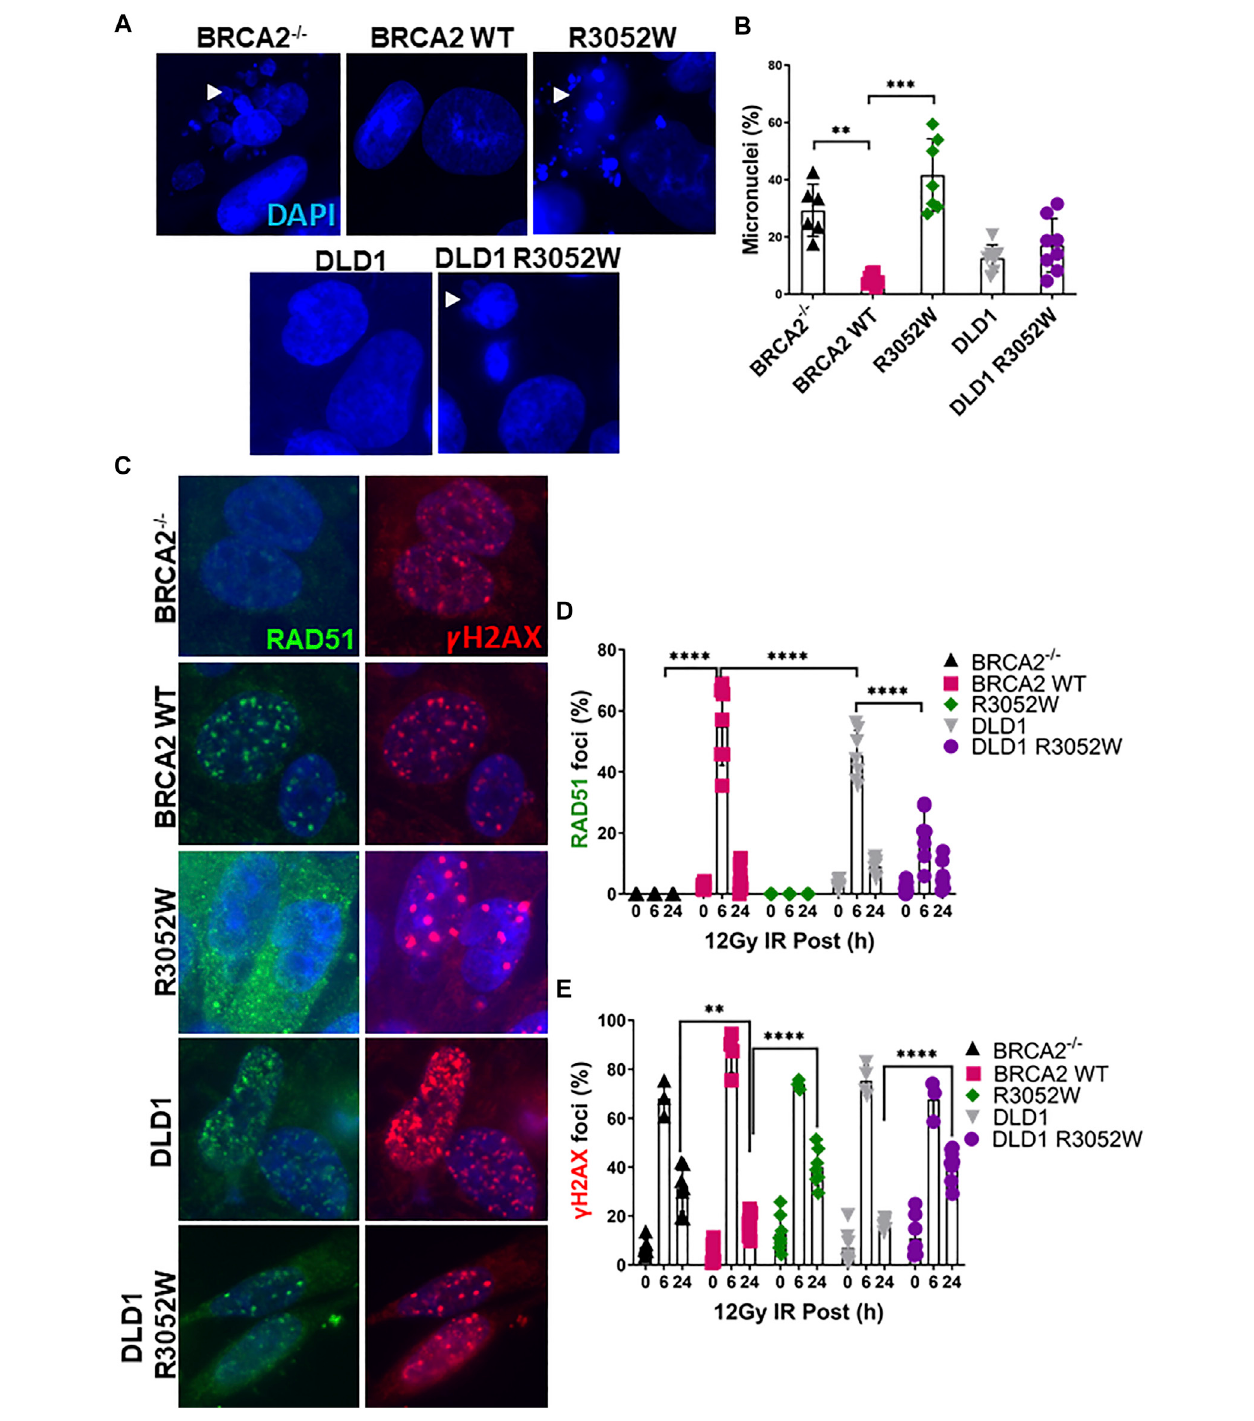
FIGURE 2 | The BRCA2 R3052W mutation exacerbates micronuclei formation and interferes with RAD51 foci formation in DLD1 parental and BRCA2 wild-type cells. (A) Representative immuno fl uorescent images of micronuclei (blue) in a DLD1 BRCA2 knockout cell line (top) expressing WT or the R3052W mutant and parental DLD1 cells (bottom) compared to a stable cell line expressing the R3052W protein. (B) Quanti fi cation of the percentage of cells with micronuclei. (C) Representative immuno fl uorescent images of RAD51 (green) and gammaH2AX (red) foci, and DAPI staining to visualize nuclei (blue). Cells were fi xed and imaged 6 h post-IR (12 Gy). (D) Quanti fi cation of the percentage of cells with RAD51 foci. (E) Quanti fi cation of the percentage of cells with gammaH2AX. (Quanti fi cation represents 3 independent experiments and statistical analysis t-test and one-way ANOVA. ** p -value < 0.01, *** p value < 0.001, **** p value < 0.0001).